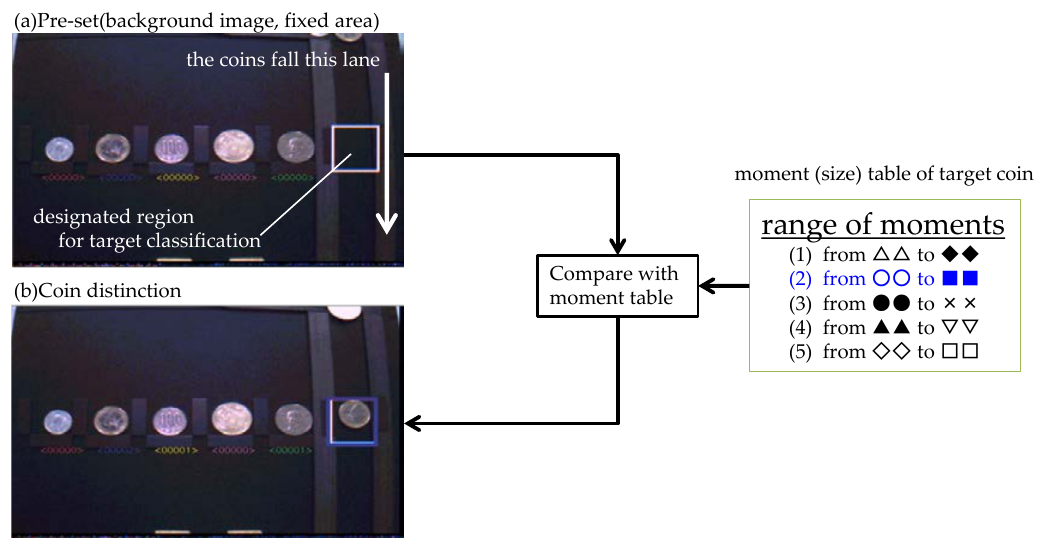
Figure 19. Multi-target classification.